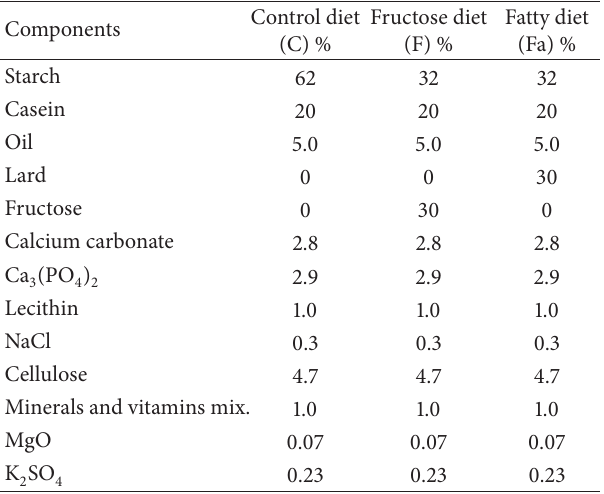
Table 1: The composition of experimental